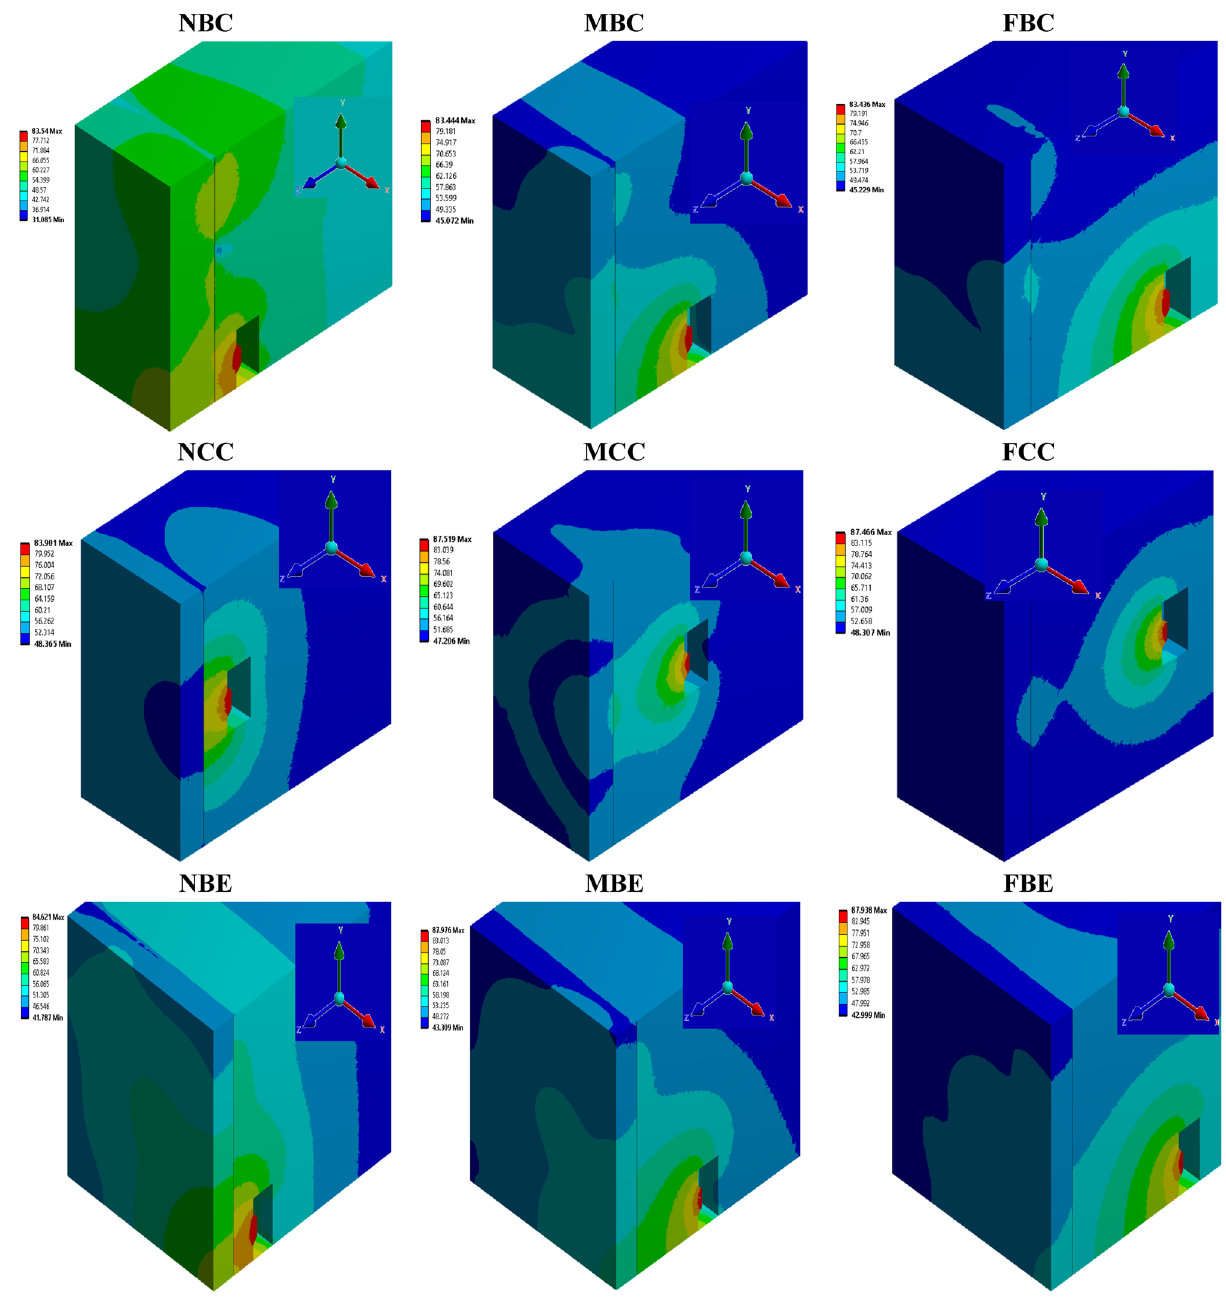
Figure 11. Sound pressure level distribution profile at frequency of 180 Hz for all sound source locations. The rationale for choosing this frequency is to fully capture the sound distribution at the radiated end of the panel where a microphone can be positioned for noise attenuation or active noise control which are typically carried out at low